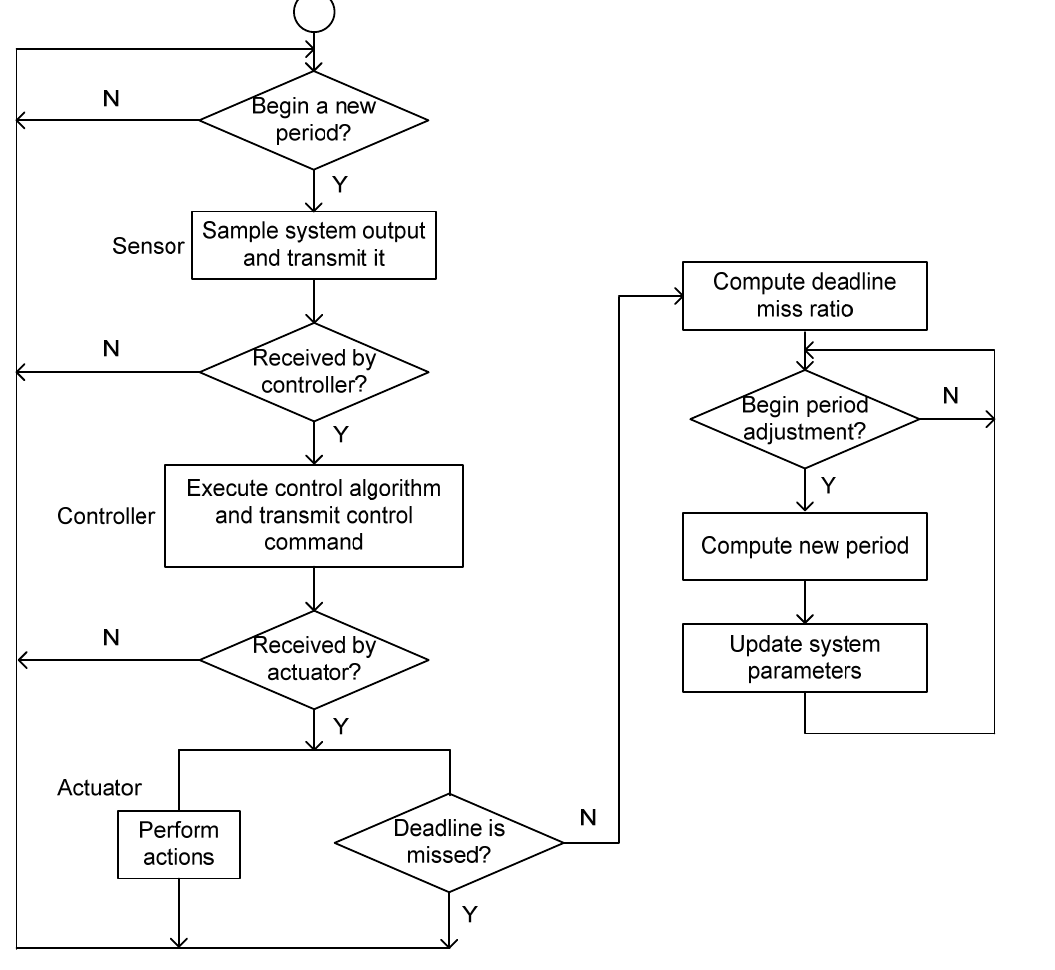
Figure 3. Flexible time-triggered